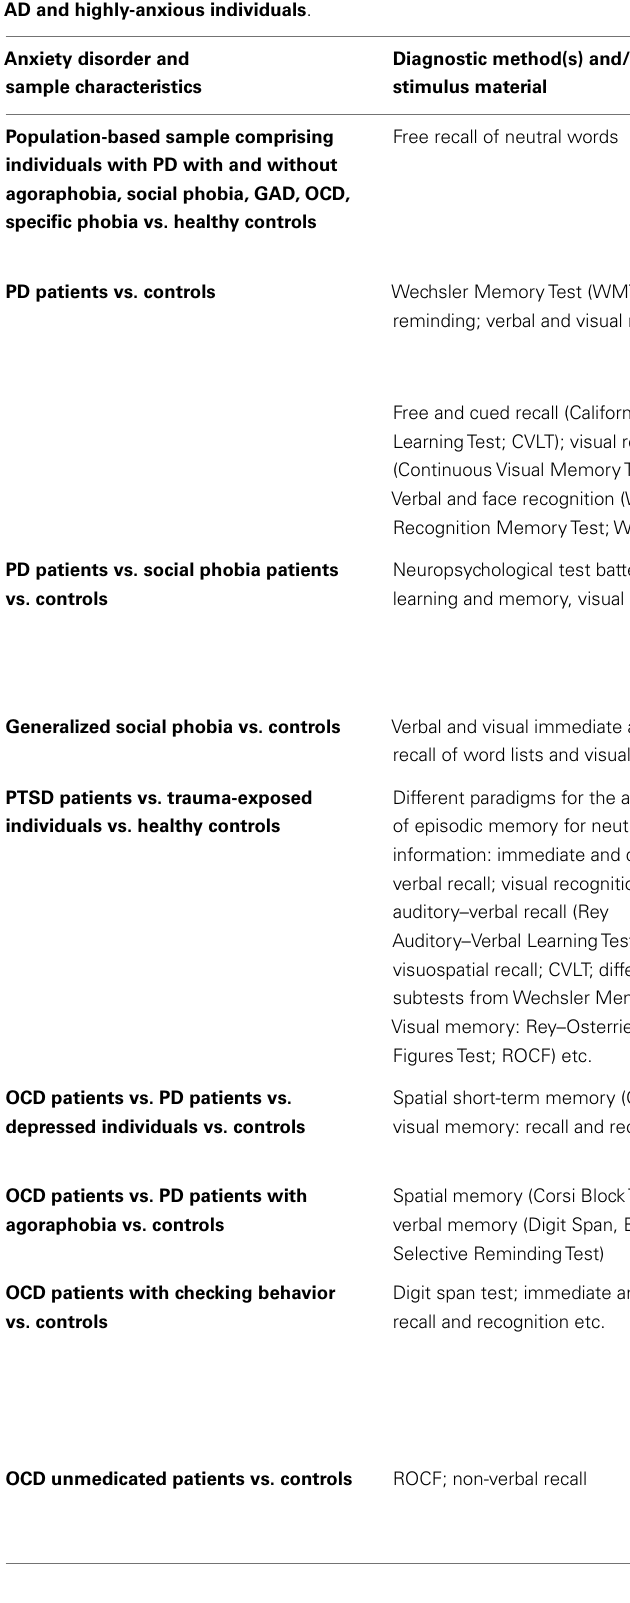
Table 3 | Diagnostic methods and findings from studies assessing episodic memory for neutral and/or disorder-unrelated material in different AD and highly-anxious individuals